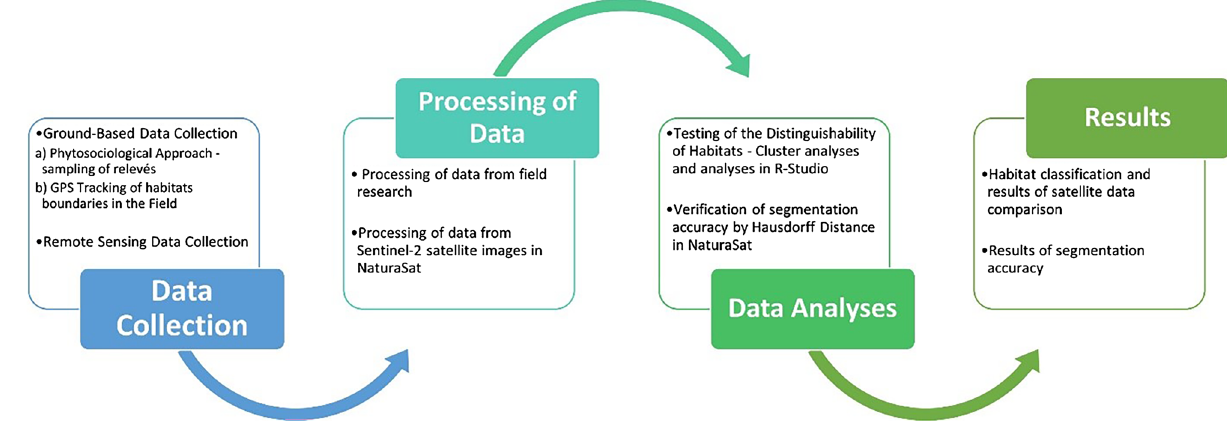
Figure 2. Flow chart of our research solution process.